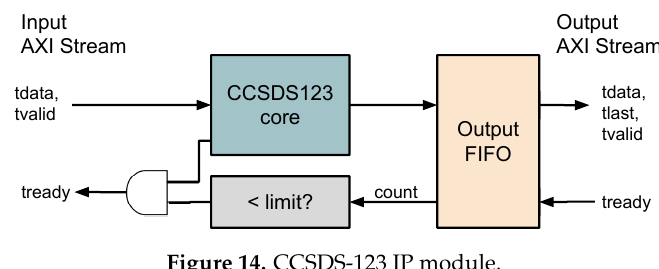
Figure 14. CCSDS-123 IP